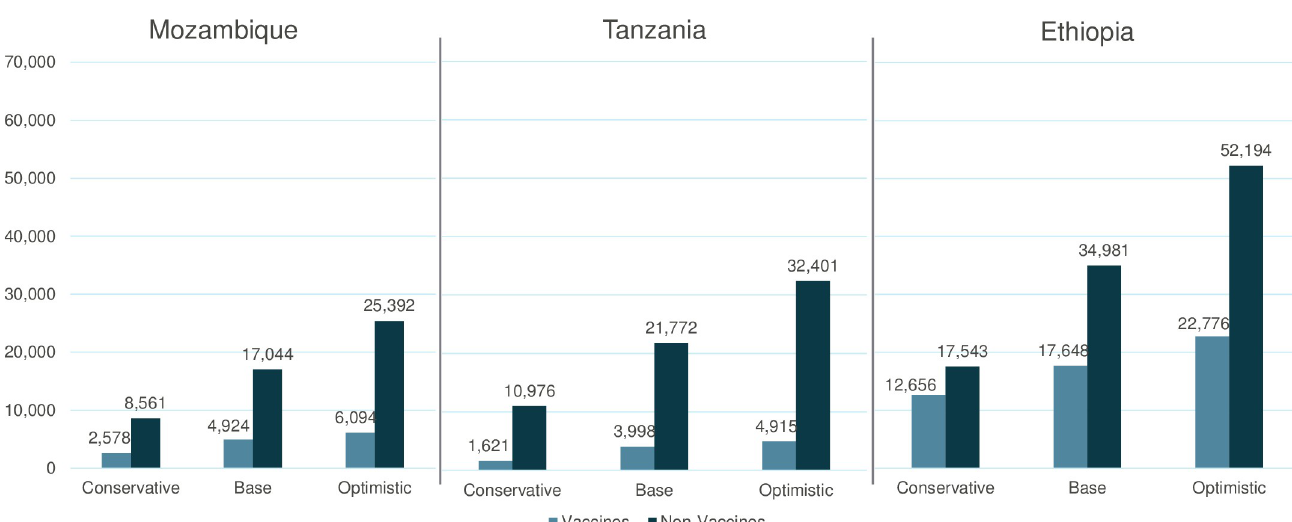
The non-vaccine interventions with the largest impact on under-five newborn and child mortality across all three geographies were treatment of neonatal sepsis and pneumonia and oral antibiotics for pneumonia (S2 Fig). Across all three countries, these interventions showed the greatest impact on newborn and child mortality when scaled with all lifesaving commodi- ties. In Mozambique, scaling up coverage of neonatal sepsis and pneumonia treatment showed the greatest impact and was estimated to save 5,269 (2,649–7,836) lives of newborns and